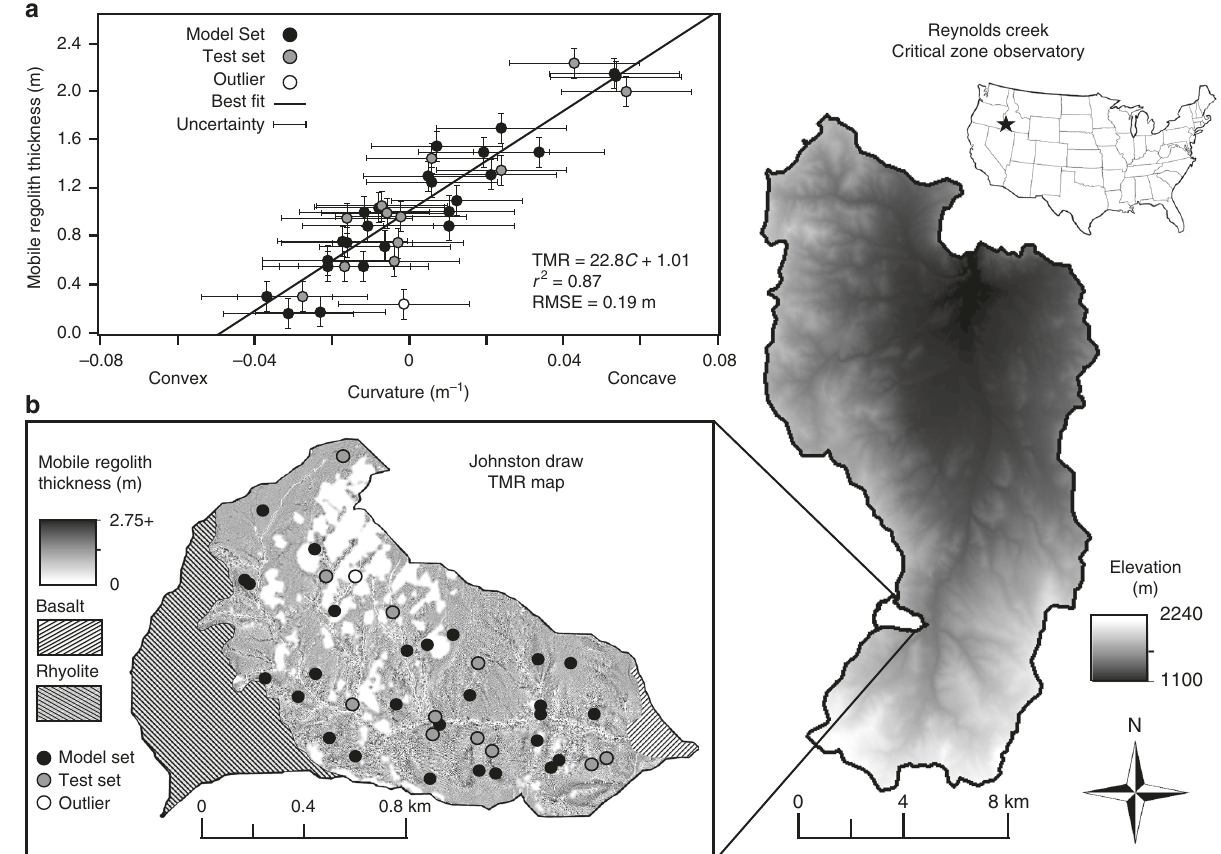
Fig. 1 Curvature and thickness of the mobile regolith plot and predictive map. a The thickness of the mobile regolith (TMR) varies as a strong linear function of curvature ( C ) in Johnston Draw. Black dots represent randomly selected build dataset (70% of sites). Gray dots represent test set to validate the model. The white dot is a location that was excluded owing to proximity to both a rock outcrop and a stream channel. Uncertainty is reported as the standard error by the Method of Moments. b Predicted TMR map for the granitic portion of Johnston Draw derived from the TMR-curvature function using a 3 m Light Detection and Ranging (LiDAR)-derived digital elevation model. Darker shades indicate larger TMR (2.75 + m) and lighter shades indicate smaller TMR (0 m) including those areas excluded as rock outcrops or streams. Hatched areas indicate non-granitic portions of the watershed that